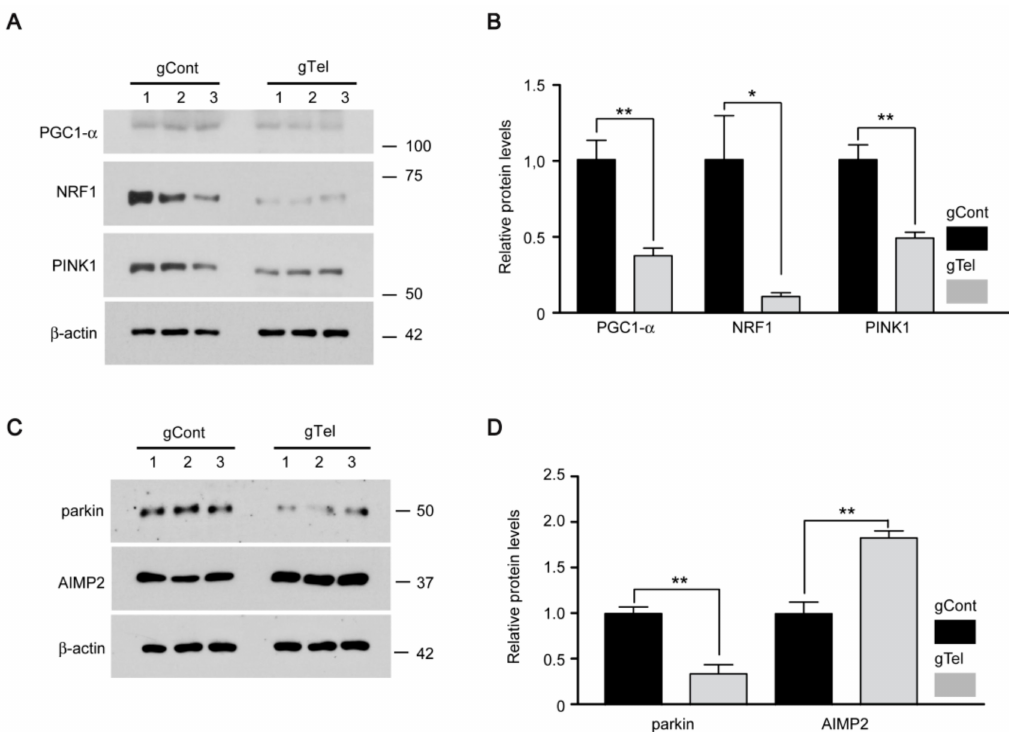
Figure 4. Alteration of mitochondria and PD associated proteins in SH-SY5Y cells with telomere removal by CRISPR-Cas9. ( A ) Representative Western blot of PGC-1 α , NRF1, and PINK1 in SH-SY5Y cells transfected with either gTel or gCont (72 h). β -actin served as a loading control; ( B ) Quantification of relative protein levels normalized to β -actin for the indicated experimental groups ( n = 3 per group); ( C ) Representative Western blot of parkin and AIMP2 in SH-SY5Y cells transfected with either gTel or gCont (72 h). β -actin served as a loading control; ( D ) Quantification of relative protein levels normalized to β -actin for the indicated experimental groups ( n = 3 per group). Quantified data are expressed as mean ± SEM. Statistical significance was determined by unpaired two-tailed Student’s t test, * p < 0.05, and ** p <